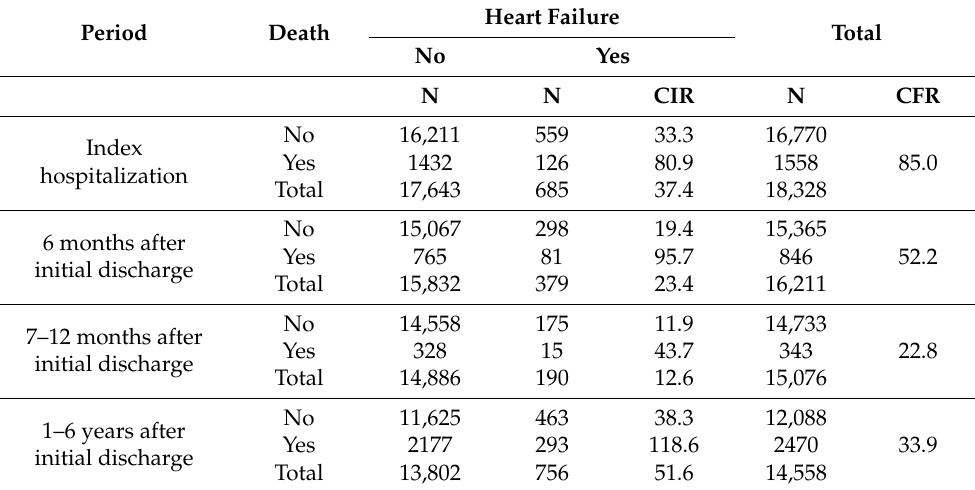
Table 3. Case-fatality rates following AMI according to observation periods.